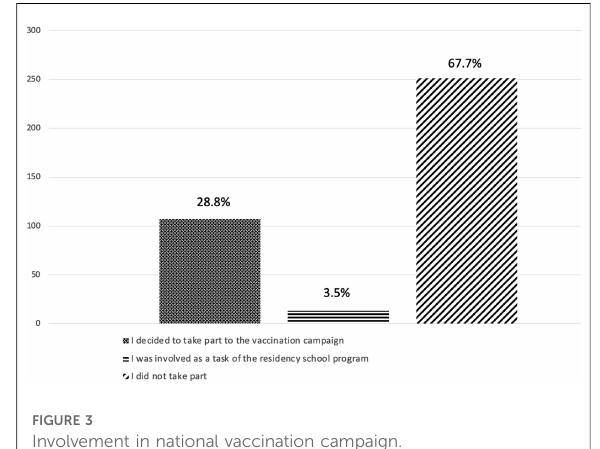
FIGURE 3 Involvement in national vaccination